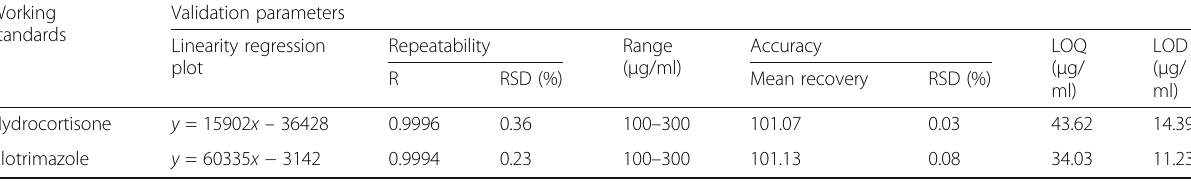
Table 2 Validation parameters for hydrocortisone and clotrimazole assay Working Validation standards